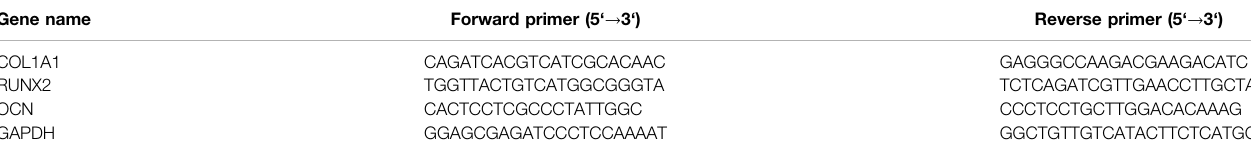
TABLE 1 | Sequences of primers for real-time quantitative PCR analysis.